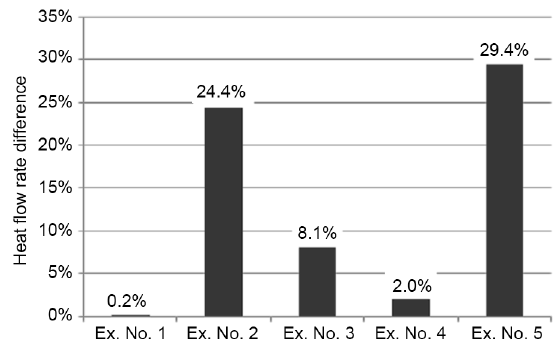
Fig. 5. Average heat flow rate differences through the cell roof constructions during daylight hours